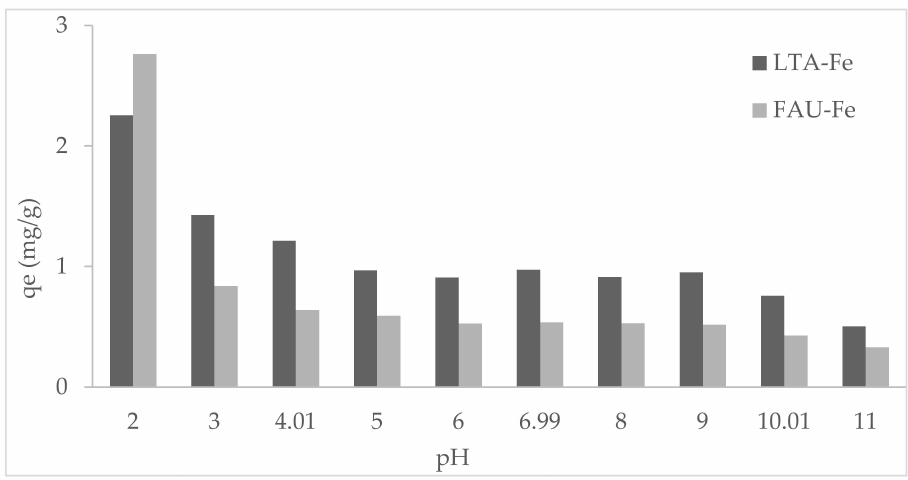
Figure 6. Phosphate adsorption ( q e ) as function of the initial pH solution pH (V: 25 mL, w: 0.25 g, and Ci: 25 mg PO 43 − L − 1 ).